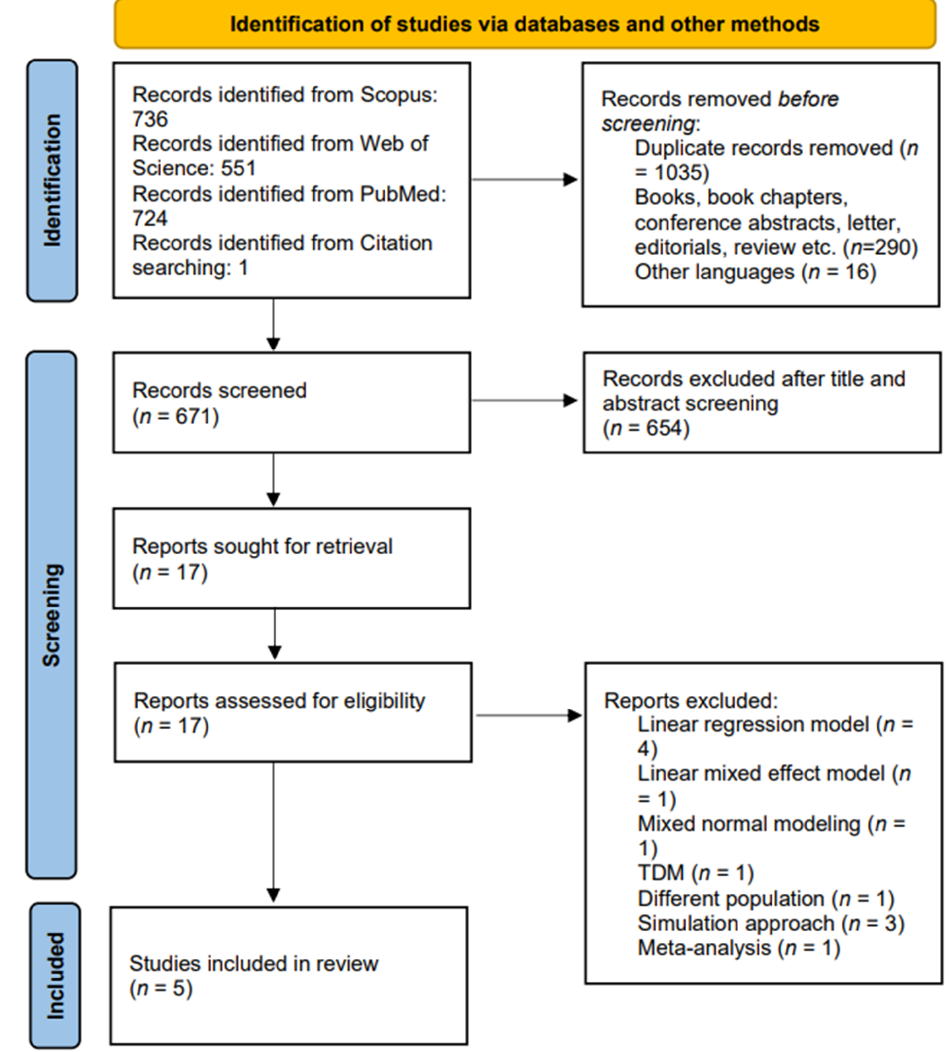
Figure 1. PRISMA Figure 1. PRISMA flowchart.